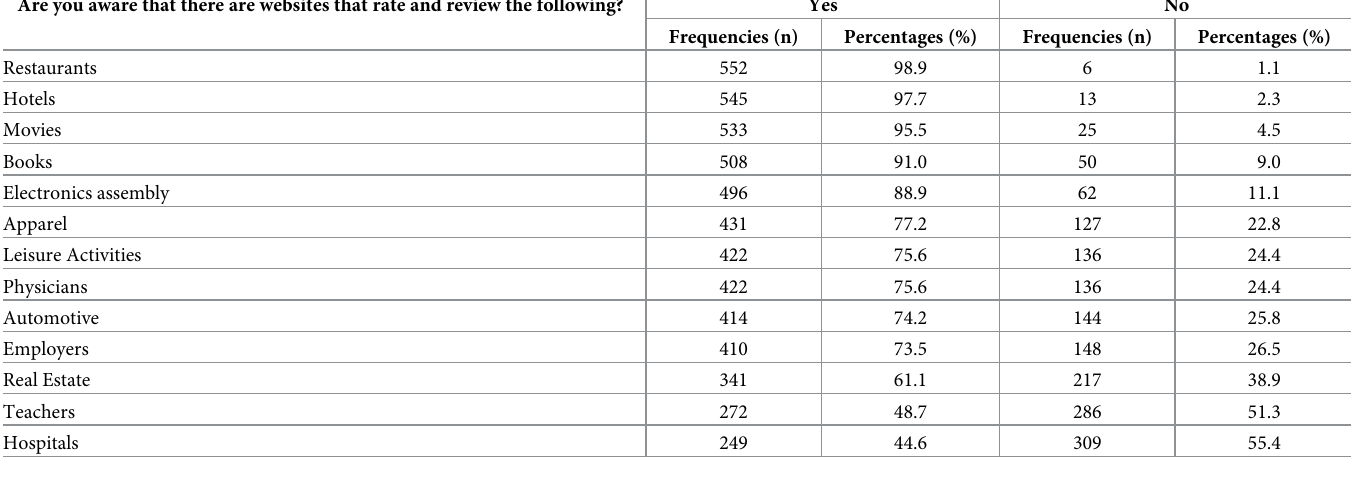
Table 4. Awareness of rating